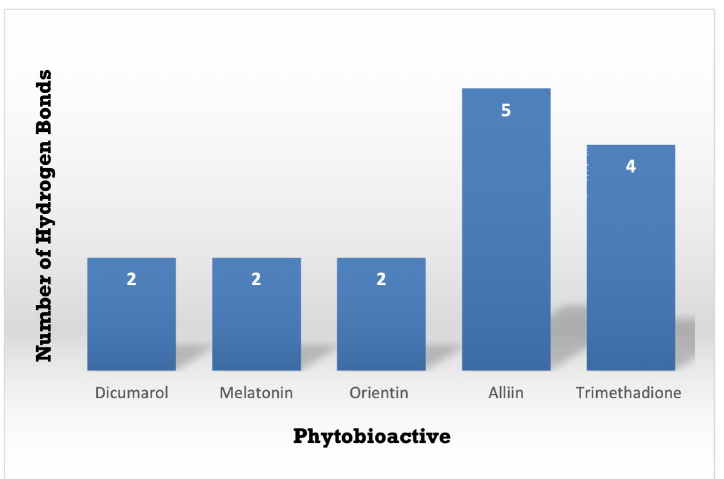
Figure 9. A Comparative study of the standard NQO1 inhibitor Dicumarol with the other po- tent phytobioactives. The X-Axis: Phytobioactives v/s Y-Axis: Number of hydrogen interactions towards